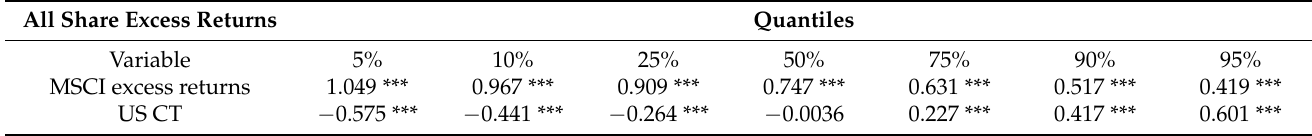
Table 1. Equities market results analysis (US carry